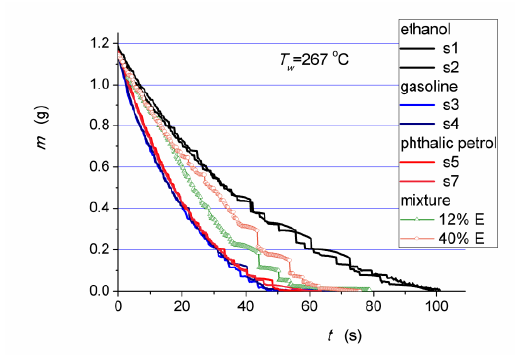
Fig. 6. Evaporation of droplets from the surface with temperature T w ~267 o C.